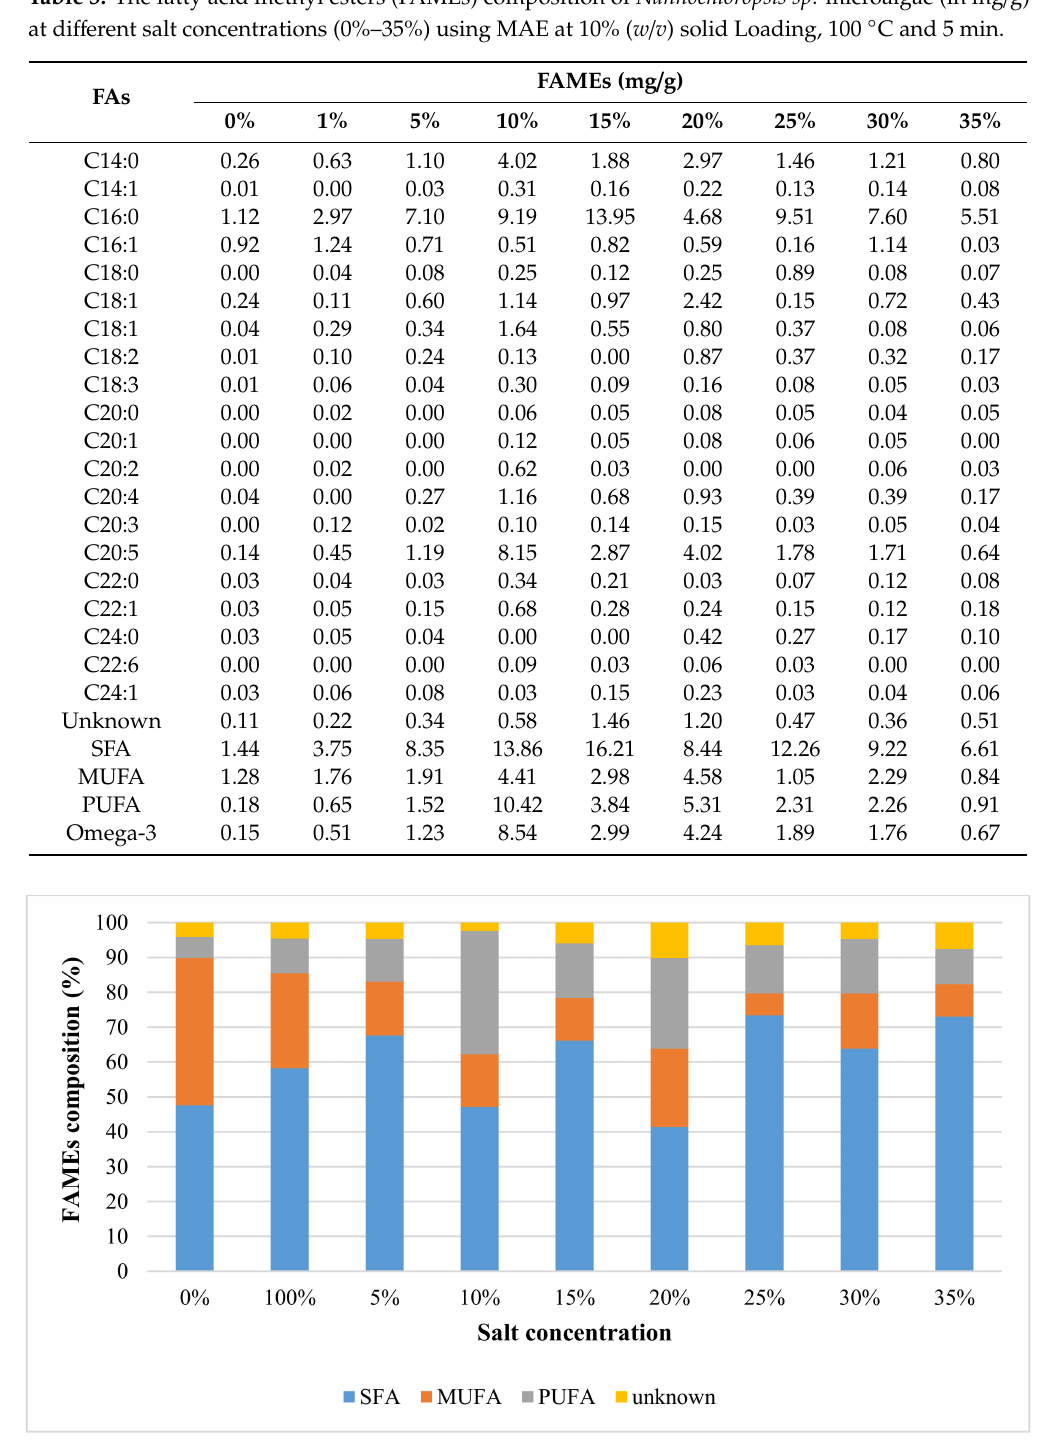
Figure 3. The distribution analysis of FAMEs classes for Nannochloropsis sp . microalgae using MAE technique at constant extraction parameters of 10% ( w / v ) solid loading, 100 ◦ C and 5 min with di ff erent salt concentrations ranging between 0 and